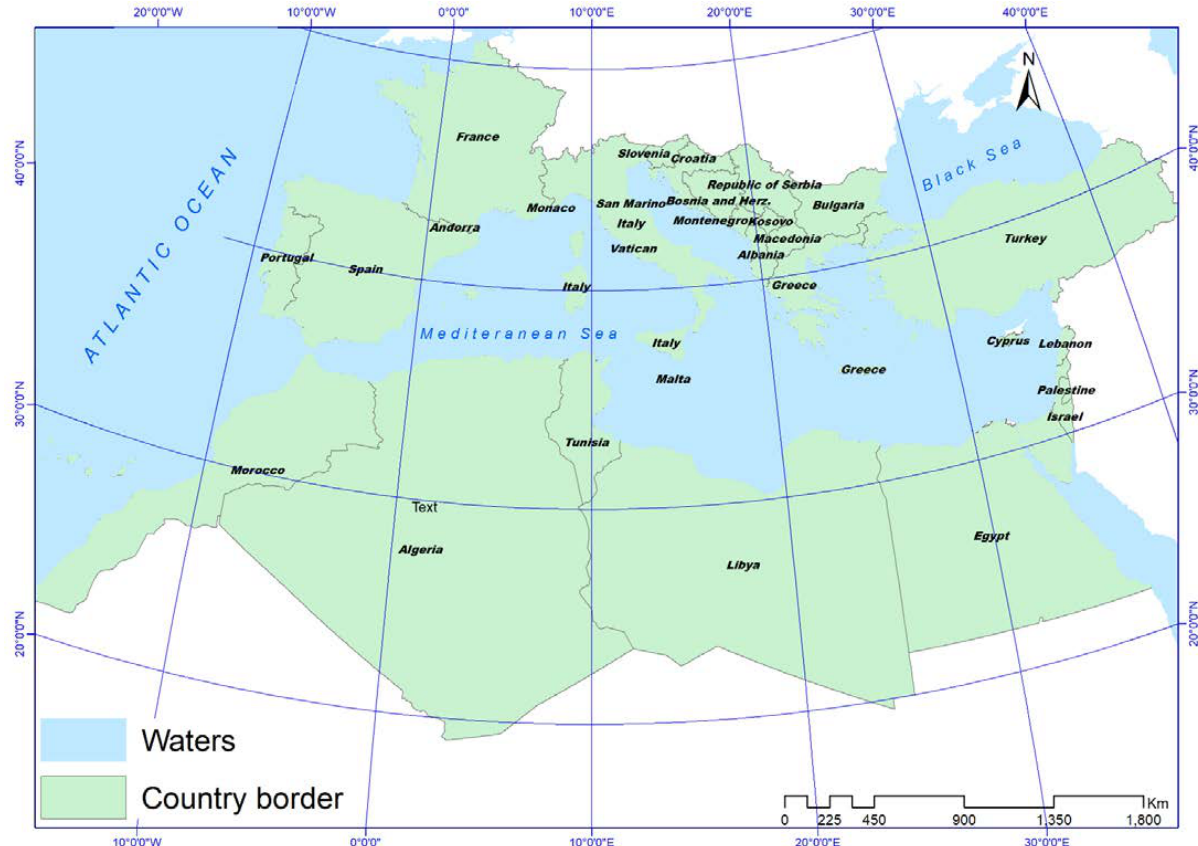
Figure 1. The geographical positions of countries in the Mediterranean Region.